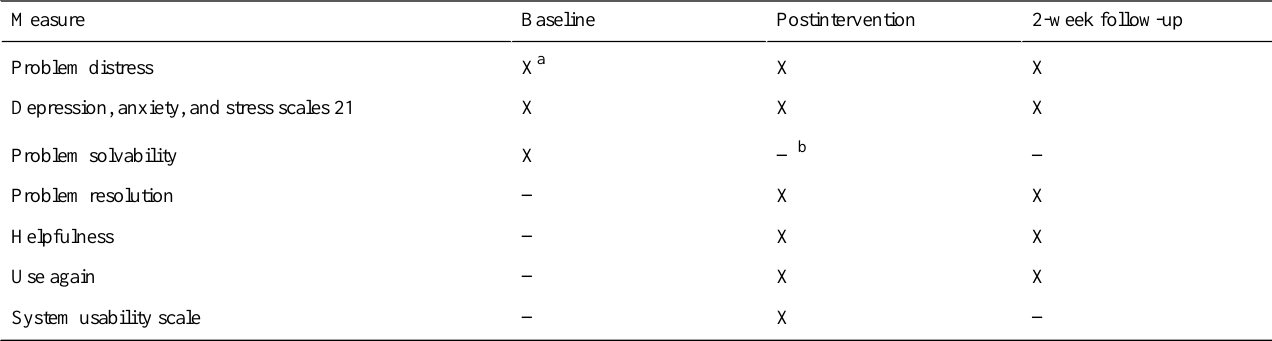
Table 1. Summary and timeframe of measure